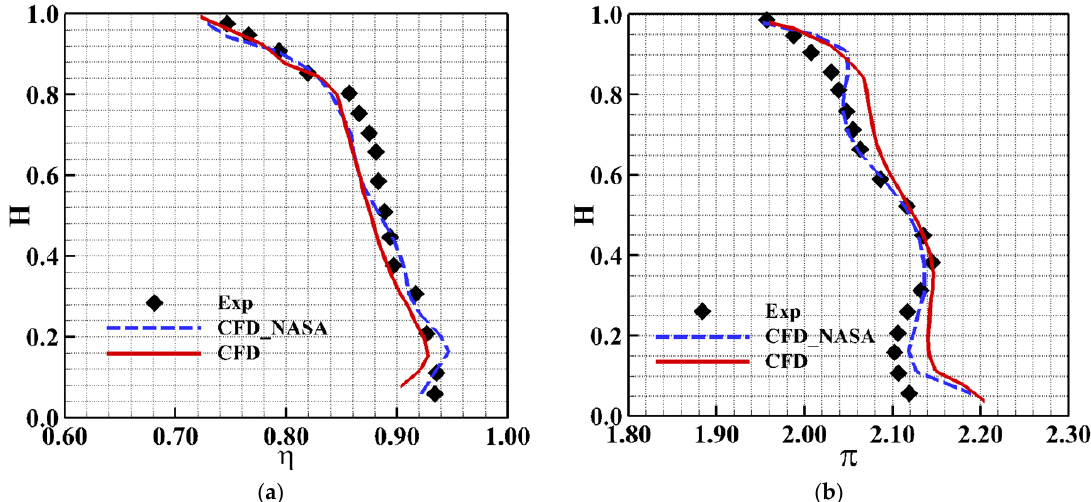
Figure 5. Aerodynamic performance comparison of the experimental results and the simulated results. ( a ) Adiabatic efficiency; ( b ) Total pressure ratio.